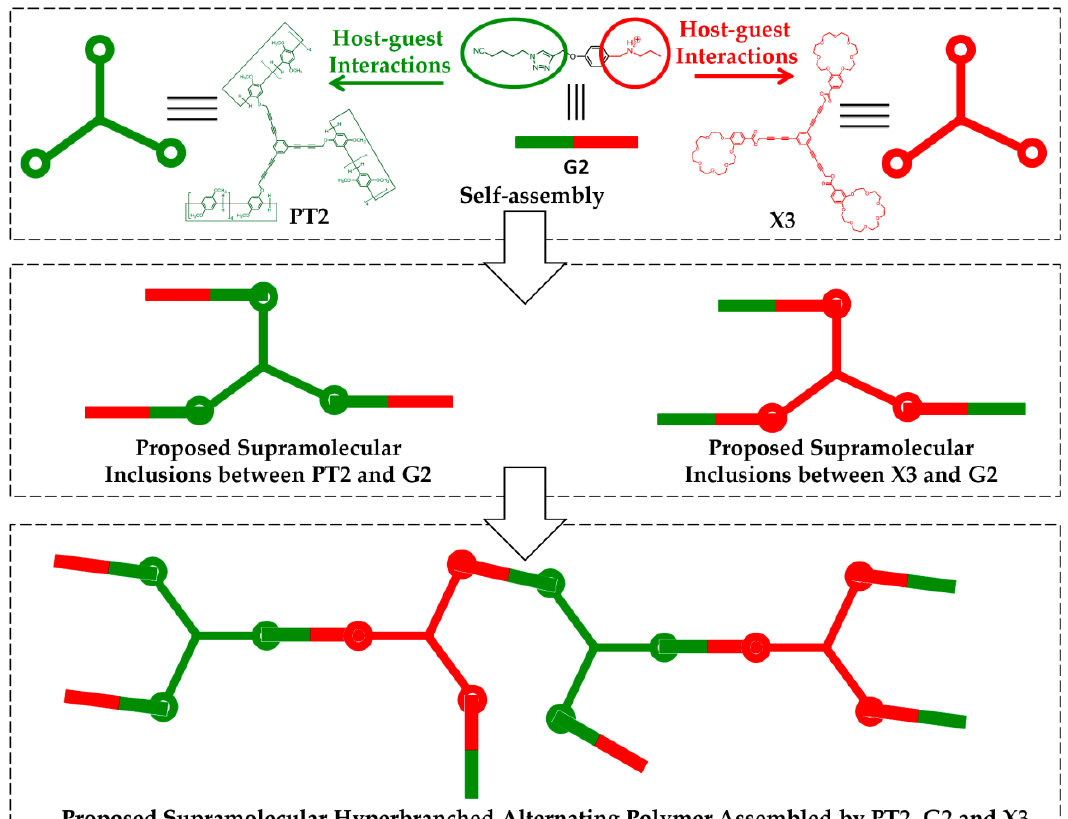
Figure 5. Graphical representation of the formation of supramolecular hyperbranched alternating polymer [20].